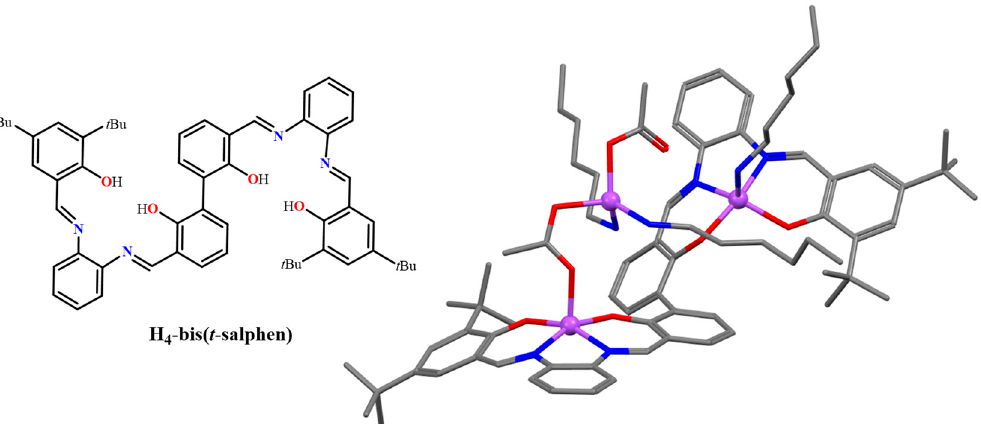
Figure 8. Molecular drawing of the H 4 -bis( t -salphen) ligand ( left ), and crystal structure of the trinuclear complex 10 ( right ) crystallized in the presence of hexylamine. Adapted from Ref. [42].